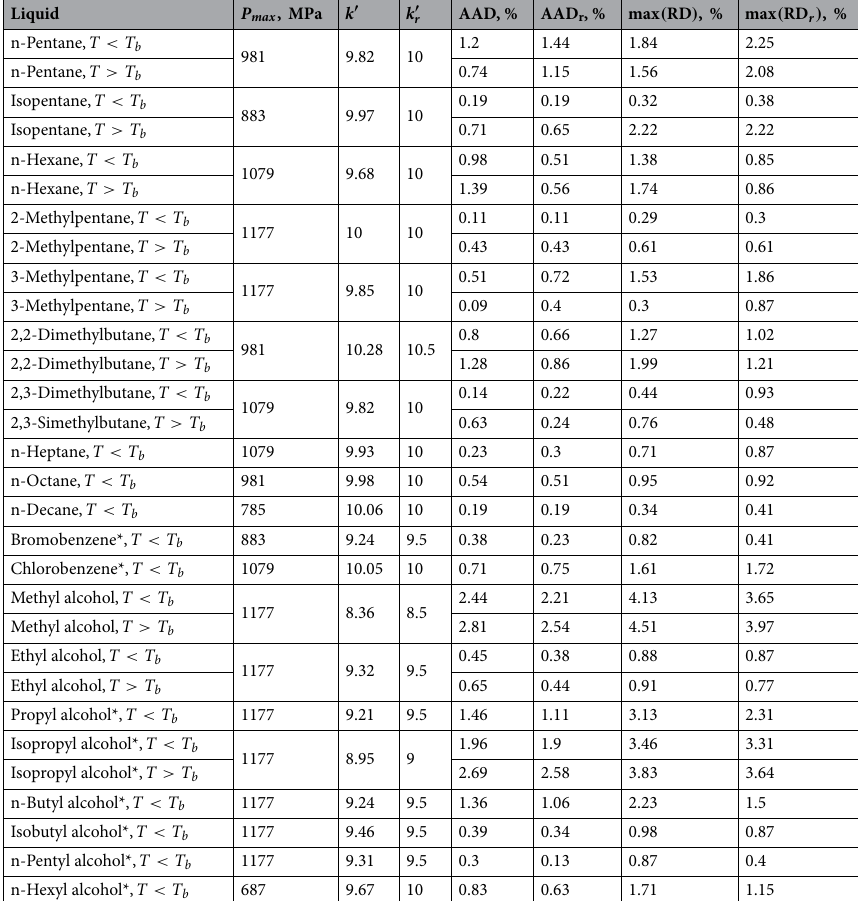
Table 1. The summary table of comparisons between Bridgeman’s experimental data 29 and the densities predicted by Eqs. (3)–(2), which indicates the average (AAD) and maximal ( max ( RD ) ) absolute relative deviations. The parameters at ambient pressure used for the predictive calculation for liquid, which names are supplied with asterisks, the correlations for the evaluated available experimental data by the NIST ThermoData Engine (TDE) 31 were used; otherwise, the data generated by the NIST REFPRPOP 30 were